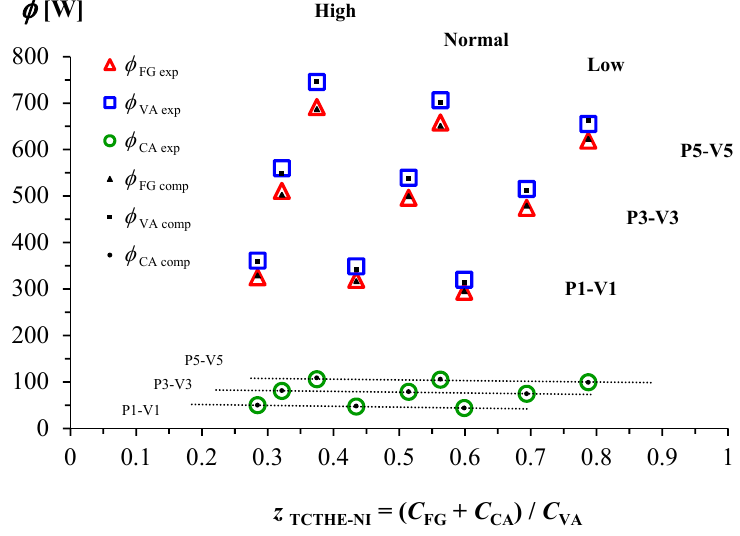
Figure 6. Experimental and computed values of heat transfer rates within the